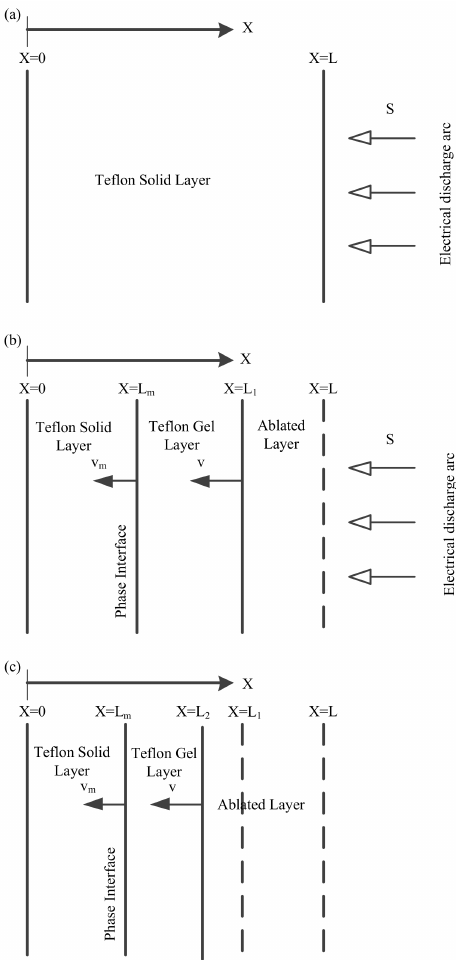
Figure 2. Schematic of the physical model and coordinates. ( a ) The first ablation stage; ( b ) The second ablation stage; ( c ) The third ablation